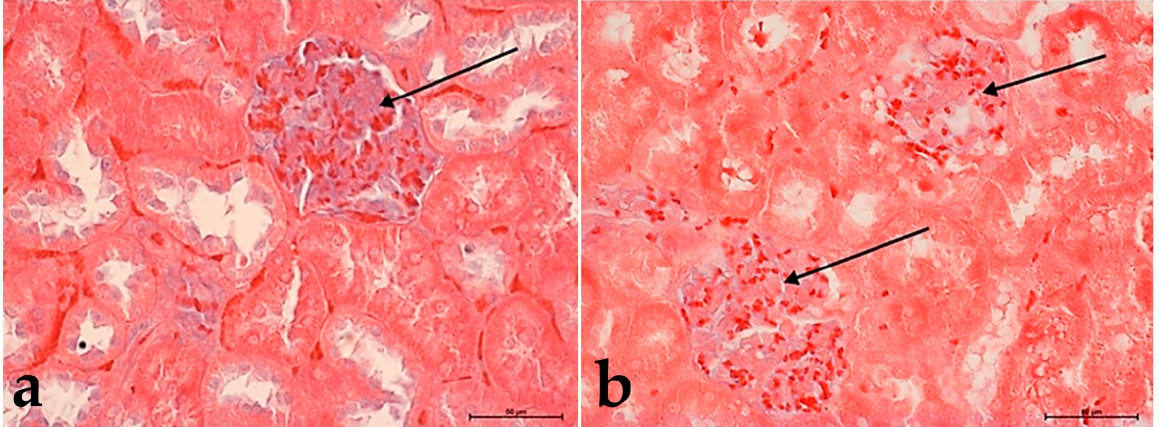
Figure 4. The changes in the kidneys’ structure in the controls group: in I , animals fed with normal ( a ) and II , high-cholesterol diet ( b ). Note the high content of proteoglycans (blue color) in the capillary tuft of the glomerulus (black arrow). Alcian blue staining. Mag. 200×. Bar scale 50 µm.